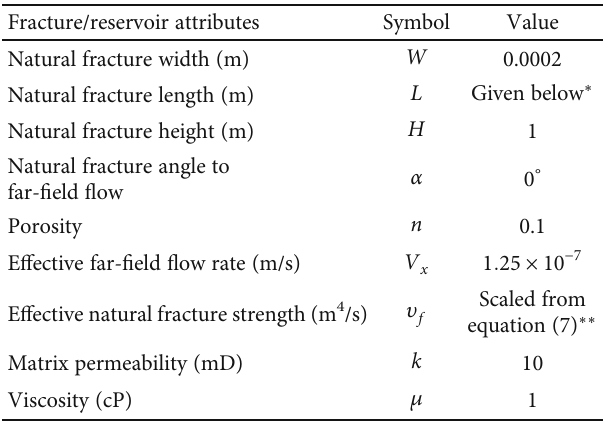
Table 5: CAM model